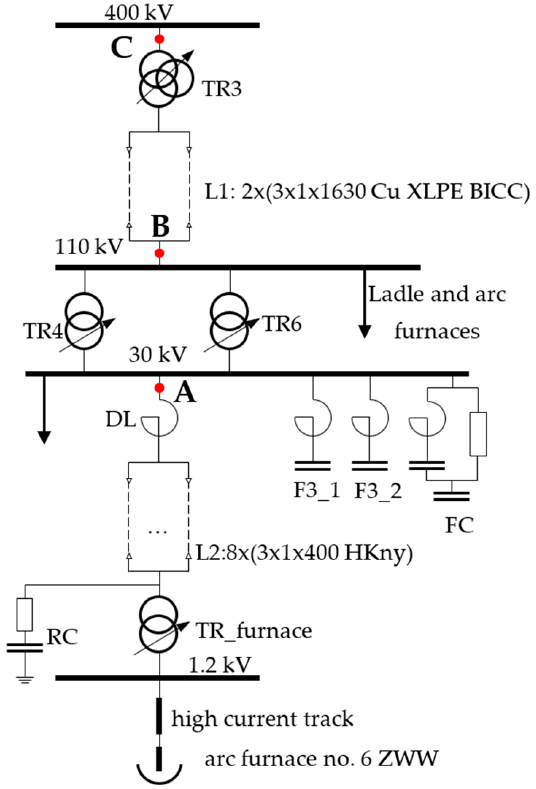
Figure 1. Scheme of the arc furnace power supply system with the selected measurement points. Table 1. Calculated values of impedance and short-circuit power in relation to the voltage of 30 kV. Short-Circuit Impedance Below the Power Percentage Share Short-Circuit Power Element Supply Element (%) (MVA) ( Ω ) 400kV mains (above TR3) C point 0.19 3.47